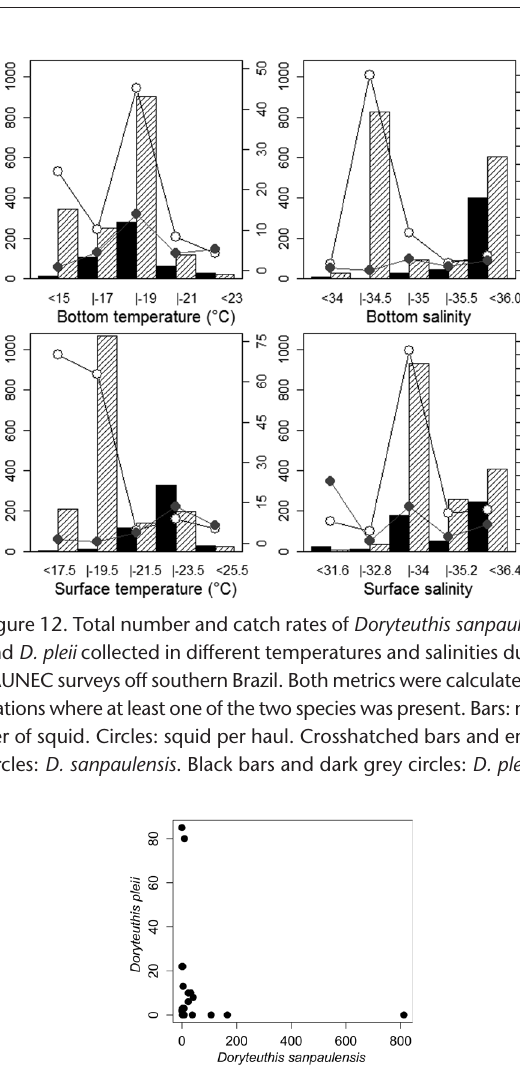
Feeding schedule in Doryteuthis